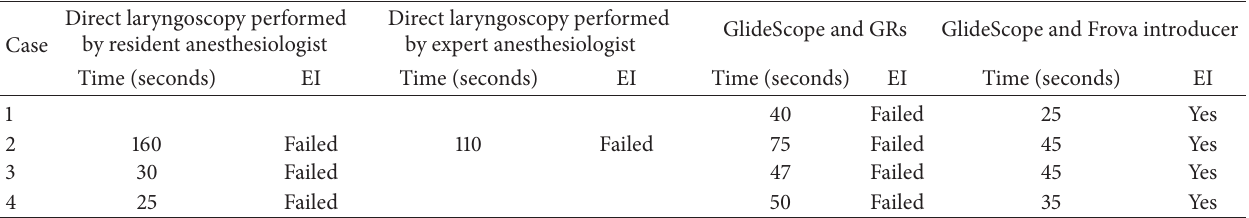
Table 1: Time of endotracheal intubation attempts performed with different devices used in our experience.